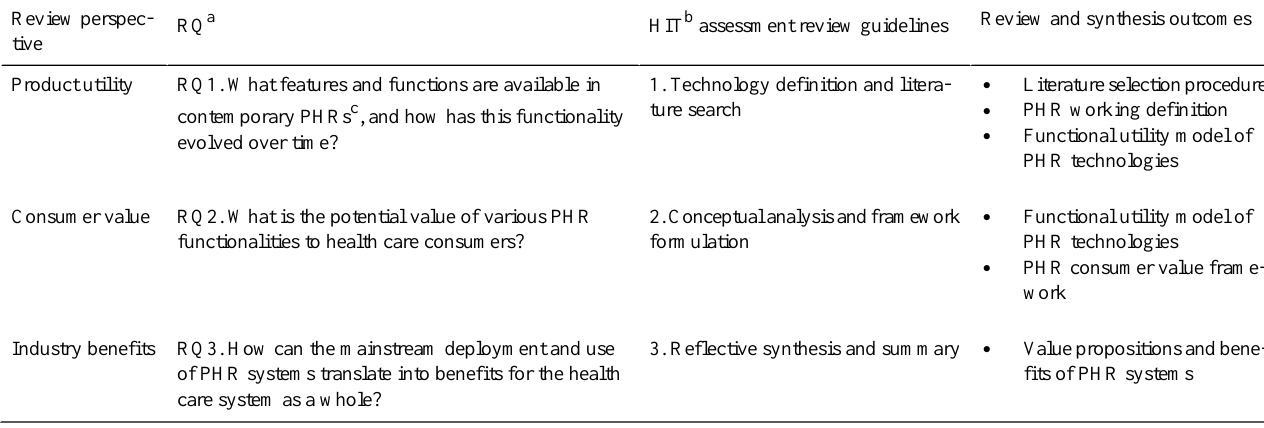
Table 1. Research questions and guidelines followed for the review and